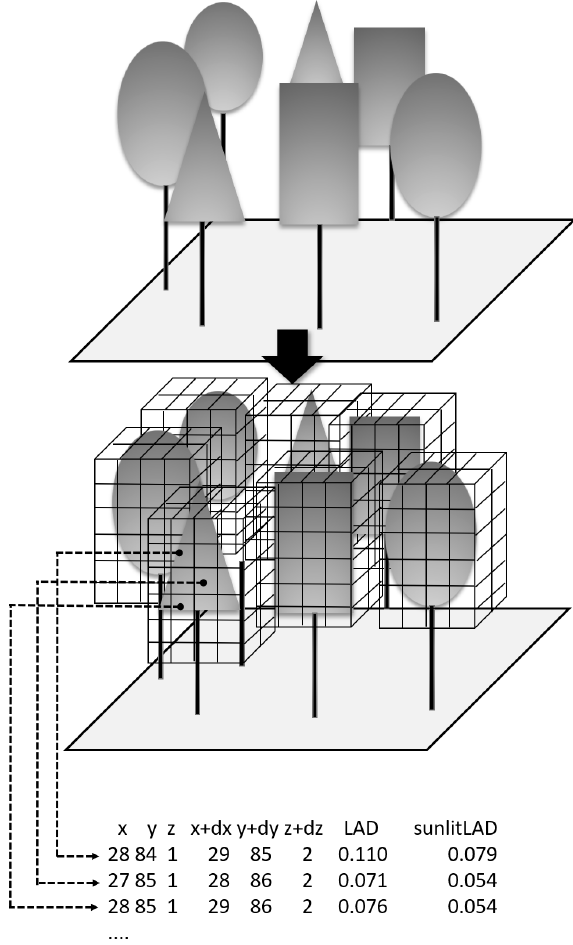
Figure 3. Voxel extraction from geometric canopy landscapes. The leaf voxel is extracted before the ray-tracing simulation. FLiES-SIF model uses the geometric object approach for the Monte Carlo ray tracing. For the SIF simulation, the ray tracing is initiated from the randomly selected positions in the forest landscape. This voxel in- formation is used to efficiently select the leaf position where SIF